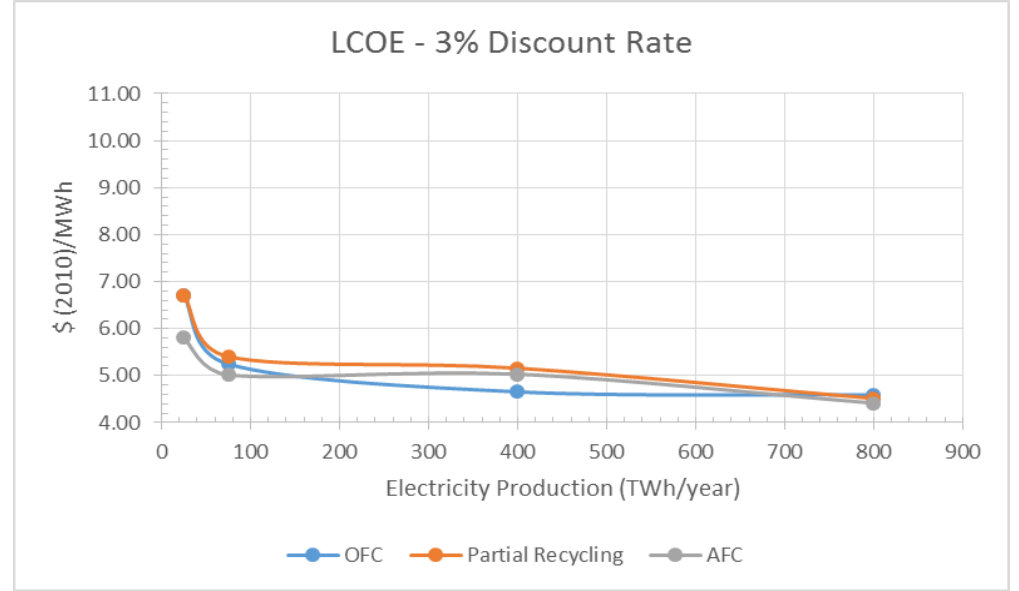
Figure 11. LCOE for different back-end strategies: 3% discount rate.